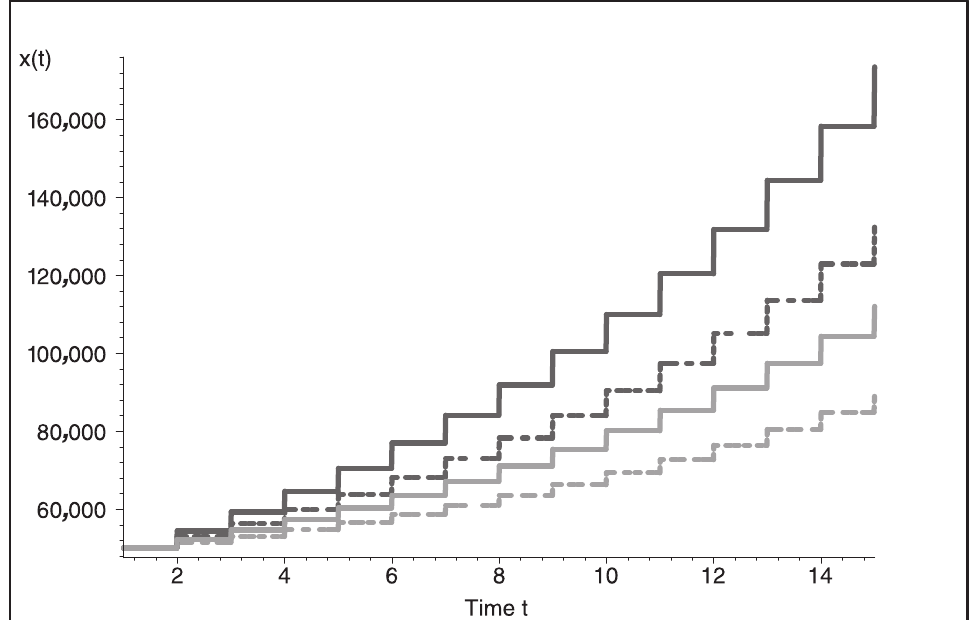
Figure 1. Population size: dark—cooperation, light—Nash equilibrium, dotted line—the model without pollution